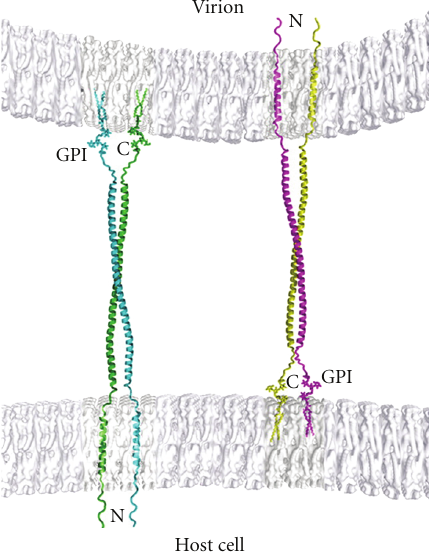
Figure 7: Hypothetical mechanism of restriction by tetherin. The cellular restriction factor tetherin can act as a bridge between two membranes. Tetherin contains a transmembrane domain at its N- terminus and is anchored to a membrane by a glycophosphatidyl linkage at its C-terminus. It also dimerizes due to a parallel coiled- coil structure between the termini of the protein. Anchorage to membranes at both ends apparently enables tetherin to “trap” virus particles, preventing their escape from the virus-producing cell. It is not known which end of the protein is embedded in the cellular membrane and which in the viral membrane. (Figure reproduced with permission from